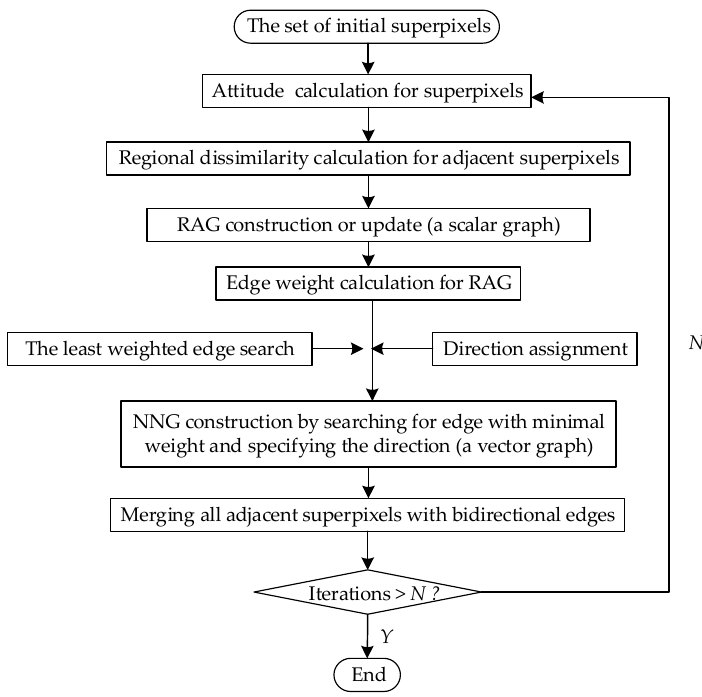
Figure 8. The flowchart of hierarchical and optimized clustering for